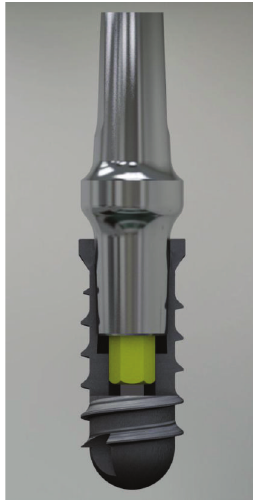
Figure 14: The implant used in this report is characterized by a cone Morse taper interference-fit (TIF) locking-taper combined with an internal hexagon. The Morse taper presents a taper angle of 1.5 ∘ .